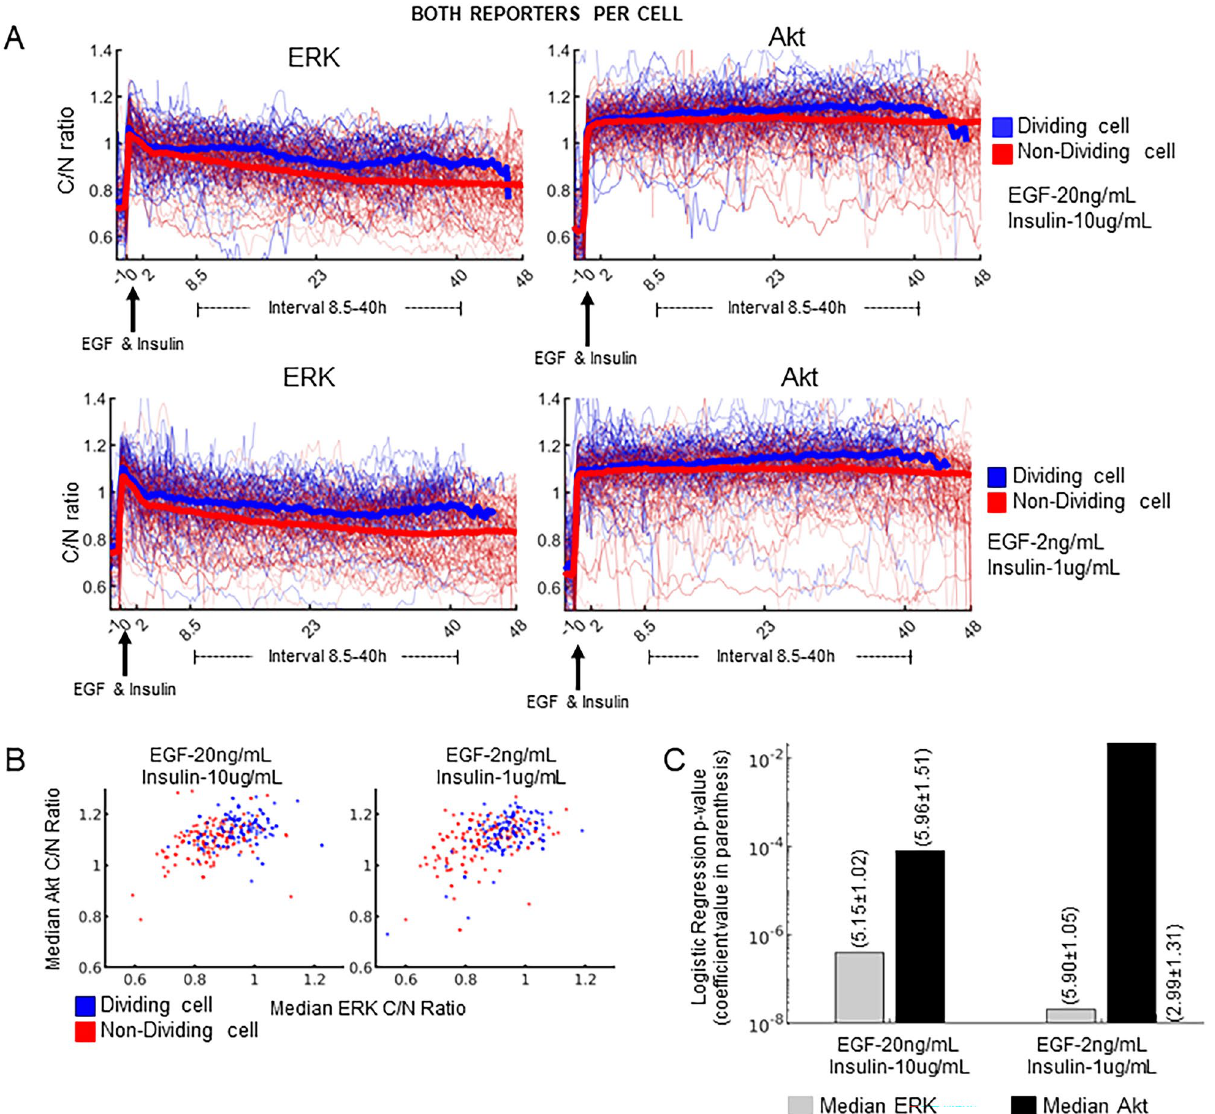
Figure 2. Evaluating the association of cell division with paired, bivariate single-cell ERK and Akt dynamics. In these experiments, cells were expressing both the ERK and Akt KTR simultaneously. ( A ) Quantified ERK and Akt dynamics for EGF and Insulin doses that match those used in culture medium (top) or ten-fold less (bottom). Single cell traces of dividing (blue) and non-dividing (red) cells are shown with thin lines, and population median (per time point) is shown with thick lines. ( B ) Scatter plot of ERK vs. Akt KTR median activity in the 8.5–40 h window from 150 randomly sampled cells. Each dot is a single cell. Dividing cells are blue and non-dividing cells are red. Left and right are high and low growth factor concentrations, respectively. ( C ) Statistical significance of logistic regression coefficients for either ERK or Akt median activity (8.5–40 h), with regression coefficients shown in parentheses above the respective bars (uncertainty is standard